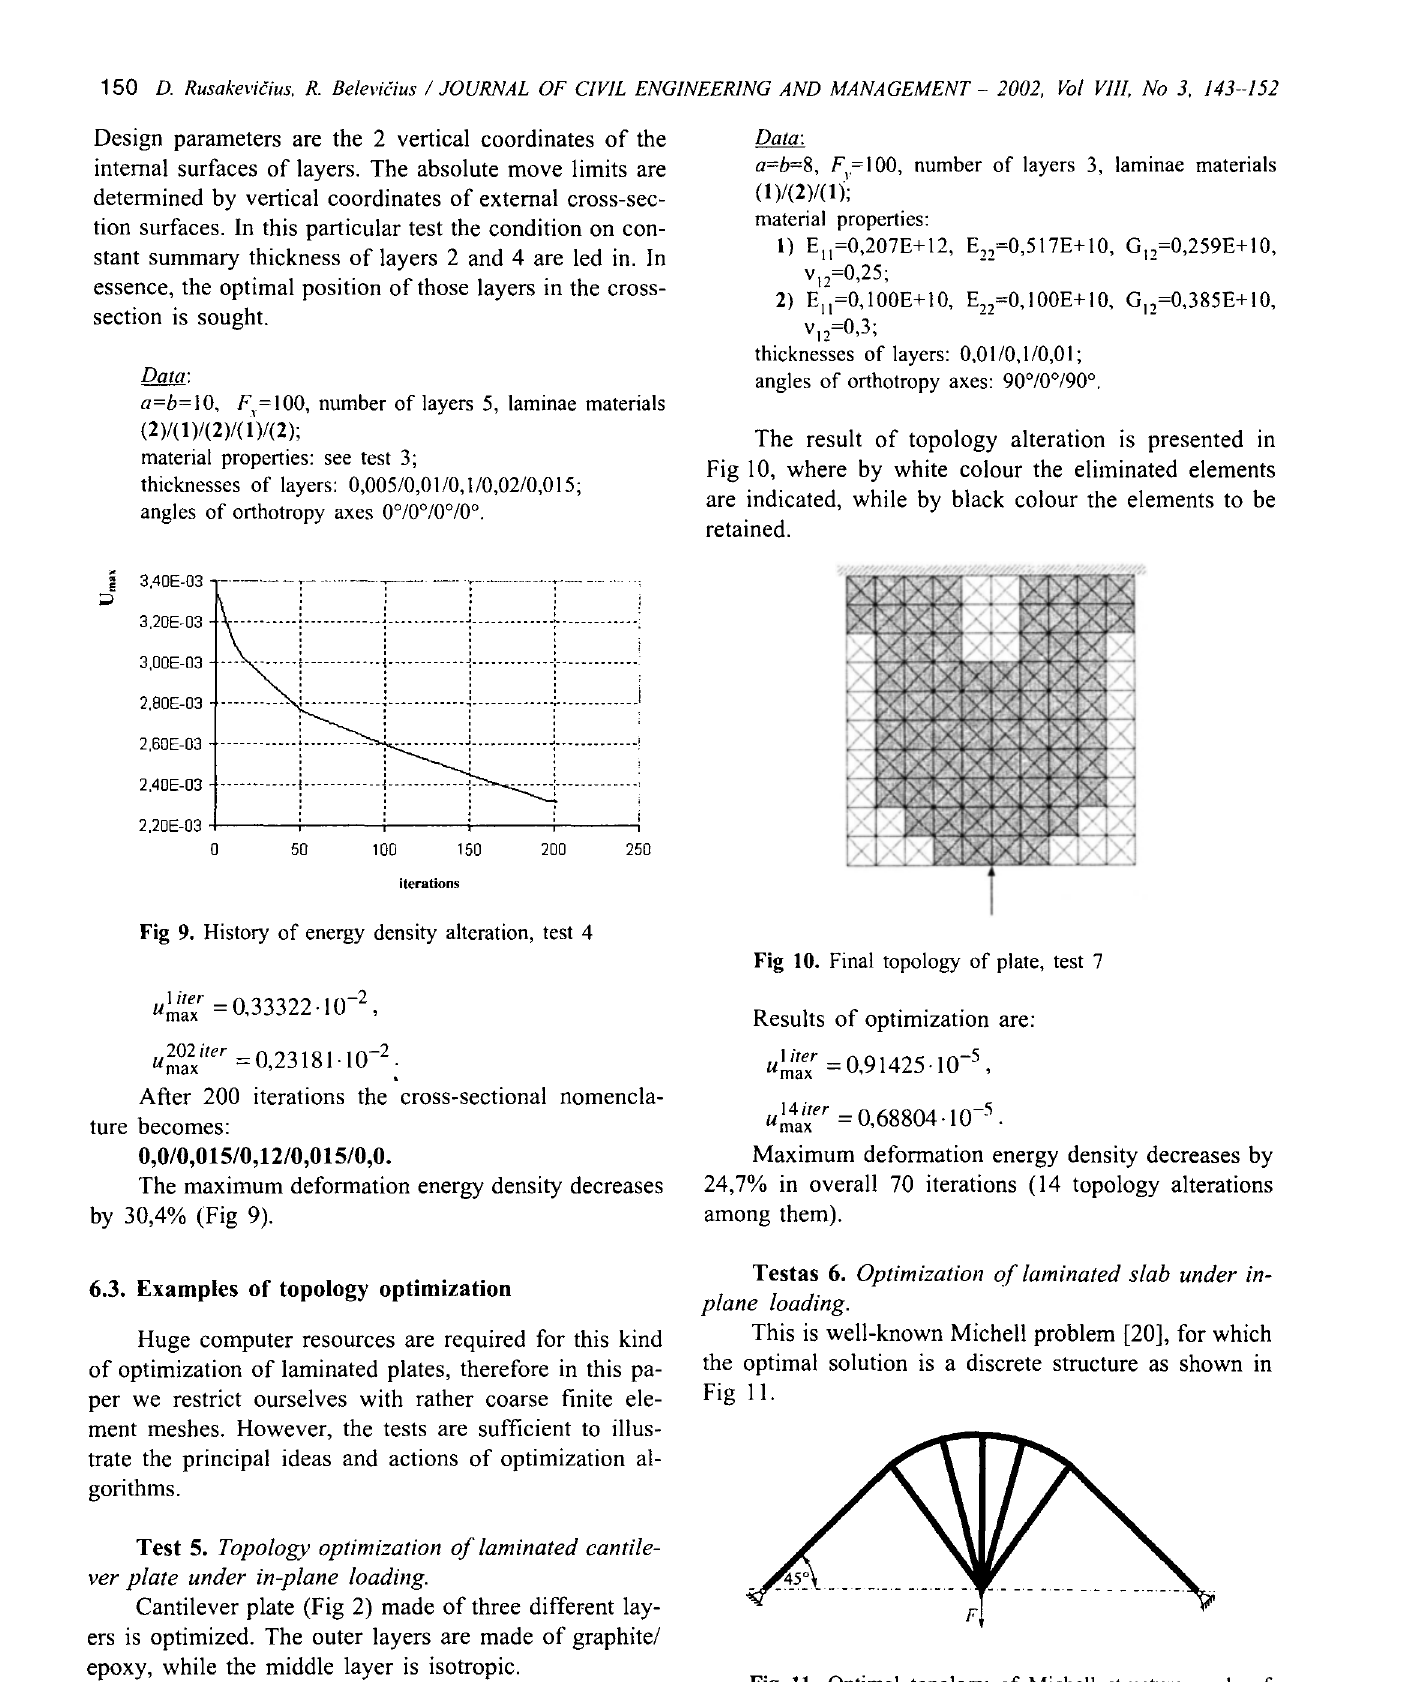
Fig 11. Optimal topology of Michell structure made of isotropic material Here the similar problem will be solved for the struc ture made of orthotropic laminated material with better properties in longitudinal